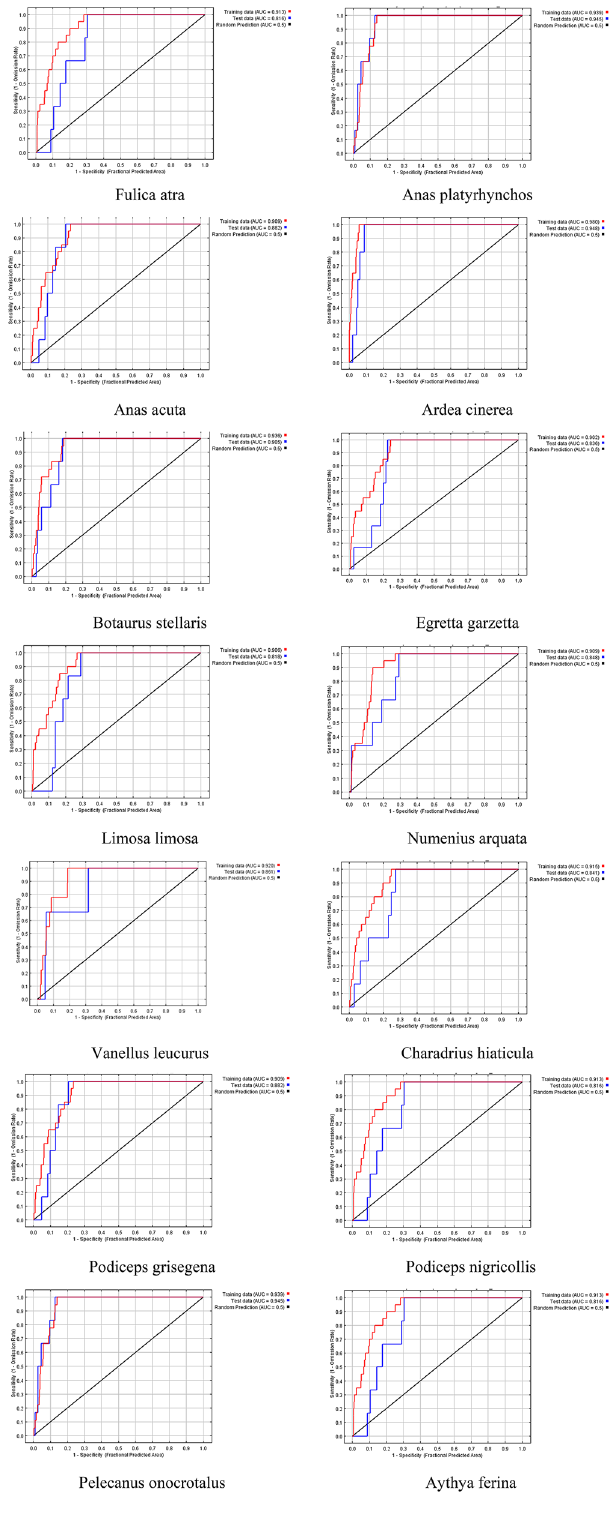
Figure 5. The Receiver Operating Characteristic (ROC) curve of the habitat suitability map for each species in Table 4. The AUC value 0.5 indicates that the model performance is not better than that of random, while values closer to 1.0 indicate better model